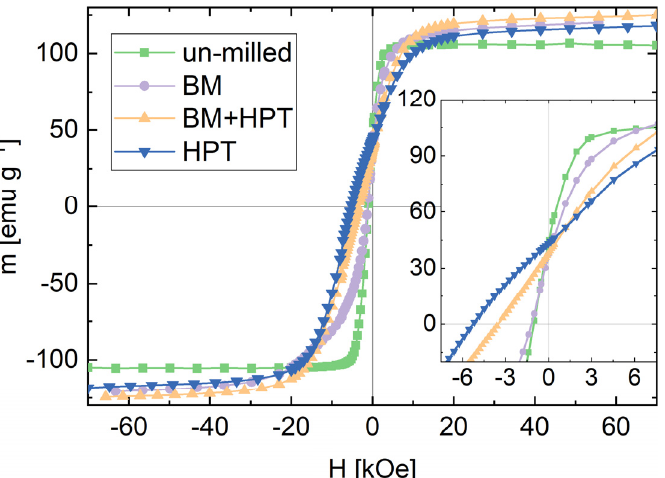
Figure 3. Demagnetizing curves starting from +70 kOe for the un-milled powder blend, ball-milled powder sample (BM), ball-milled and HPT-deformed powder sample (BM + HPT) and un-milled and HPT-deformed powder sample (HPT), exemplified for samples with the highest SmCo 5 -content. The inset shows the demagnetizing branches in more detail. Table 1. Magnetic properties measured by SQUID magnetometry. Ball-milled and powder samples are denoted as ‘BM’, ball-milled and HPT deformed powder samples as ‘BM + HPT’ and un-milled and HPT deformed powder samples as ‘HPT’. The prefix ‘rad’ and ‘tang’ denotes measurements with the magnetic field applied parallel to the radial or tangential HPT-disc direction, respectively. For all other listed HPT-deformed samples without any prefix, the field is applied parallel to the axial HPT-disc direction. The suffix 1–3 corresponds to the chemical composition. H c depicts the coercivity measured in Oe, M s is the saturation magnetization determined as described in the text and M r denotes the remanence, both given in the specific mass moment emu g − 1 .